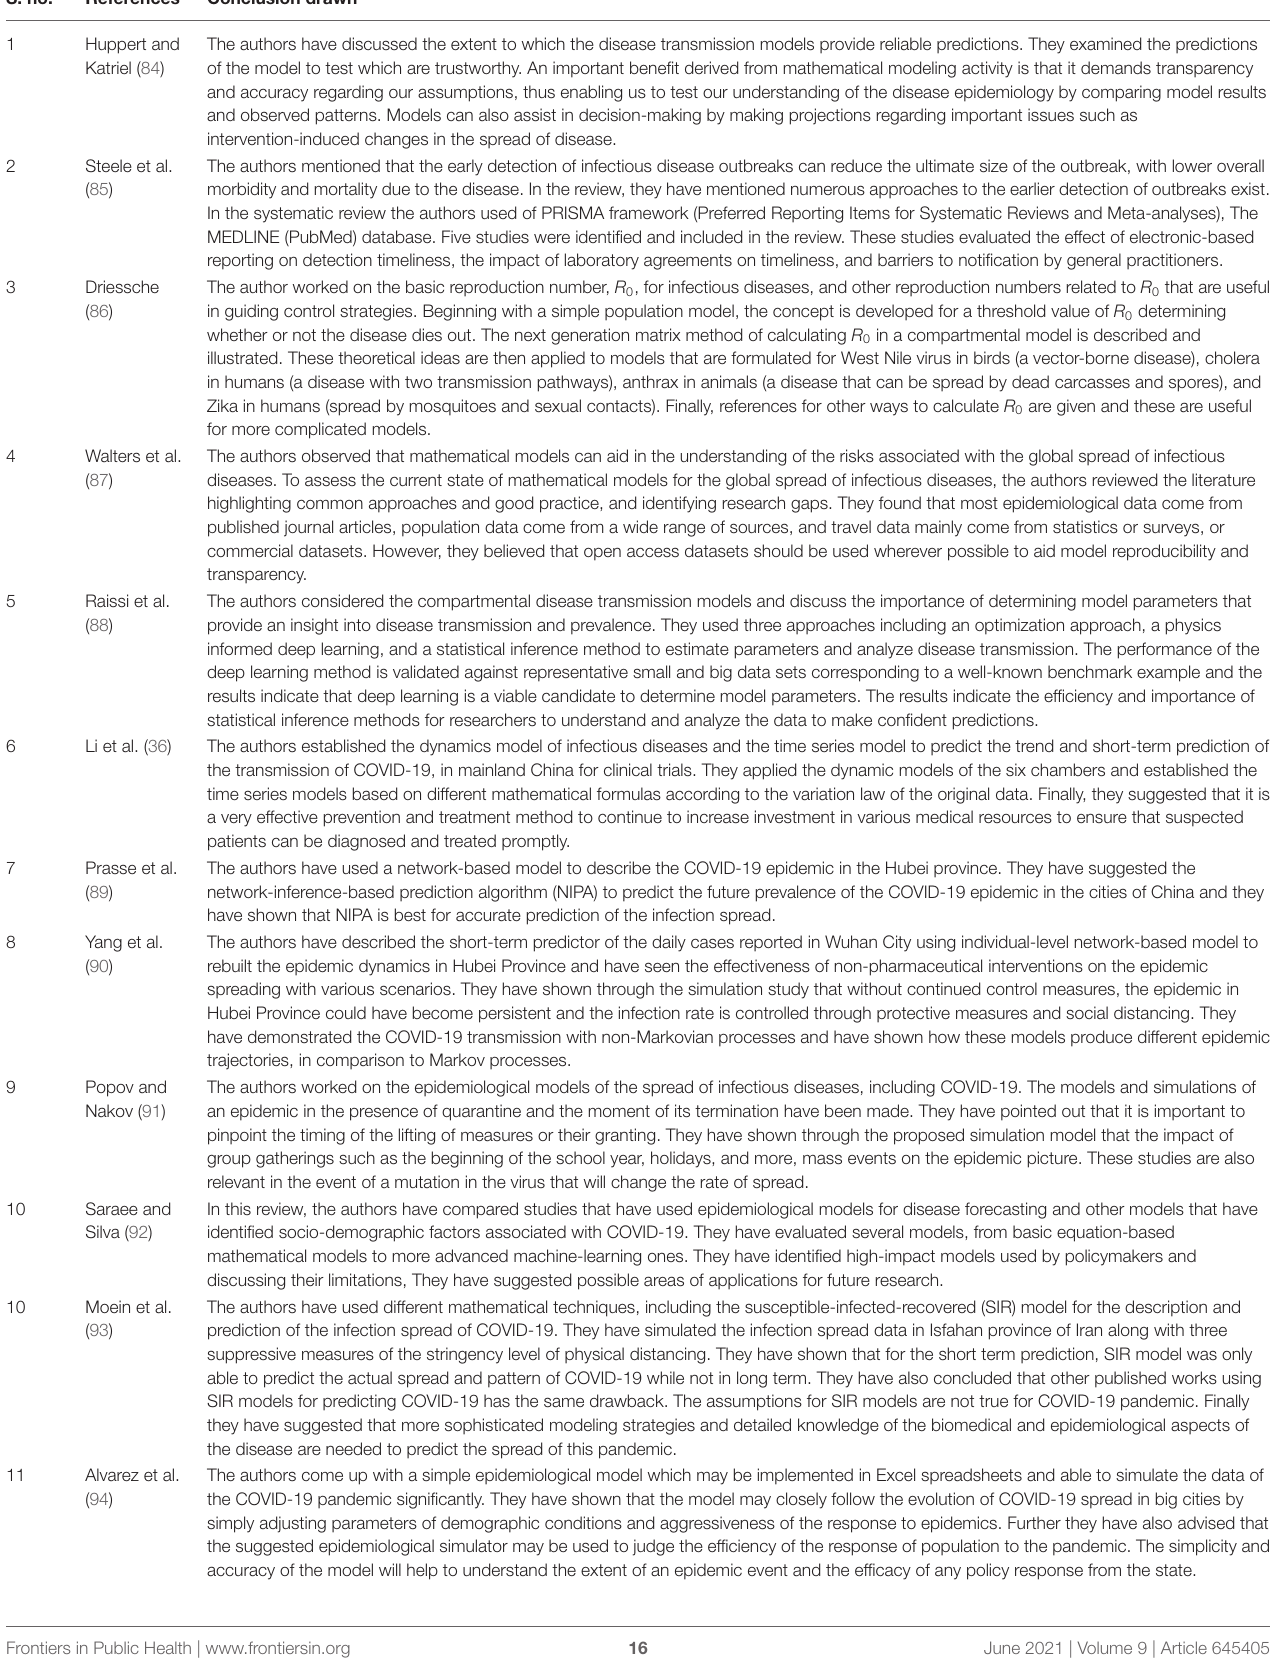
TABLE 5 | Various epidemiological models for different infectious